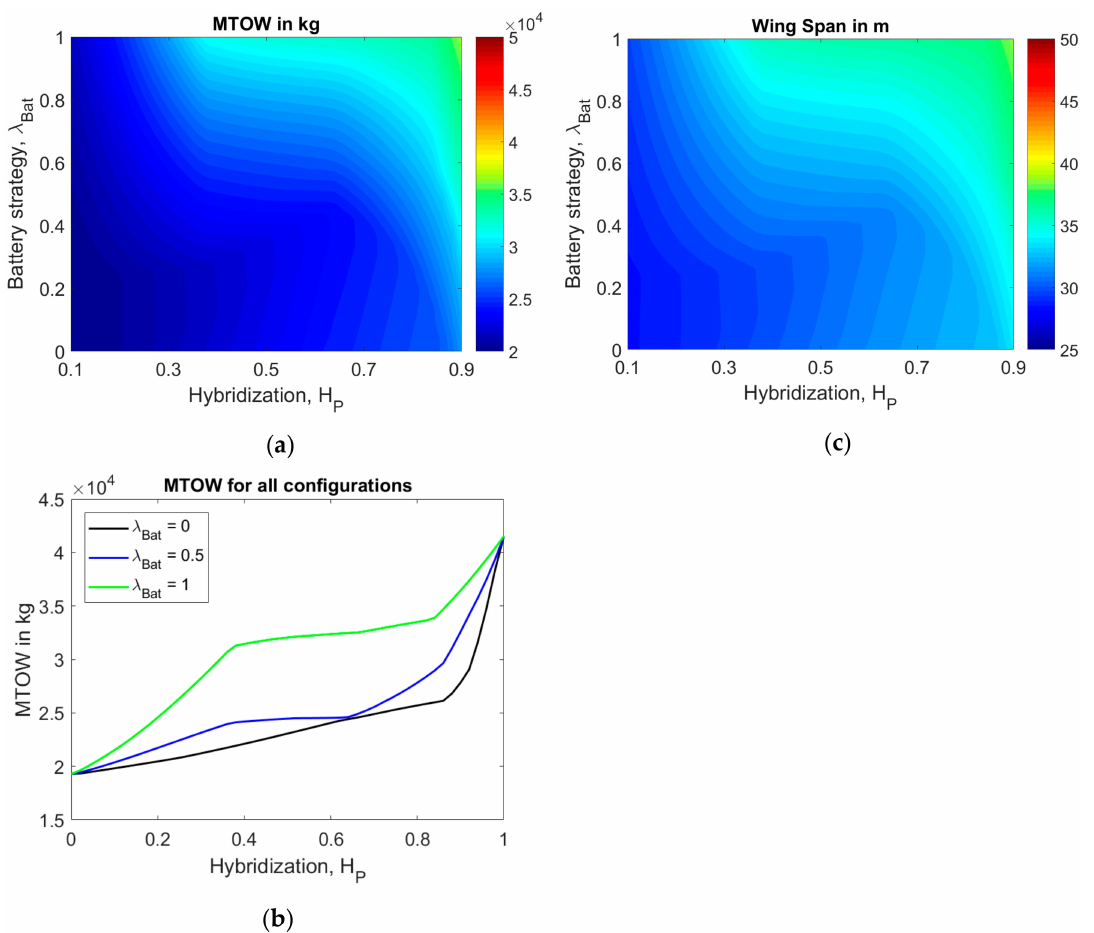
Figure 5. OAD parameters in case of Battery 2 (0.65 kWh/kg, 1 kW/kg): MTOW in kg for ( a ) Hybrid electric aircrafts ( H P from 0.1 to 0.9); ( b ) all degrees of hybridization (exemplary λ Bat ); ( c ) Wing span in